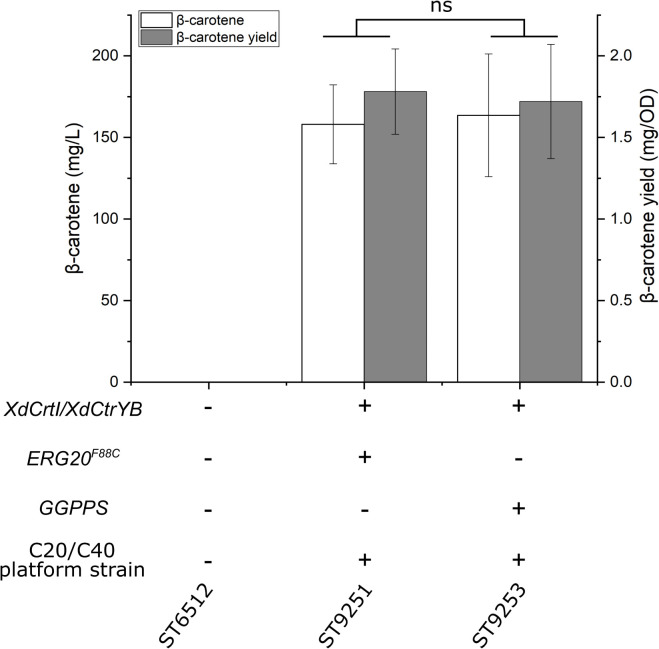
β-carotene production by the diterpene/carotenoid platform strains. XdCrtI, X. dendrorhous phytoene desaturase; XdCrtYB, X. dendrorhous bi-functional phytoene synthase/lycopene cyclase; ERG20F88C, mutated version with geranylgeranyl diphosphate synthase activity; GGPPS, geranylgeranyl diphosphate synthase. The diterpene/carotenoid (C20/C40) platform strain contains the following gene overexpressions HMG, ERG12, ACL, SeACS, and IDI, while the native squalene promoter was swapped (pERG11_SQS). Average values and standard deviations for each strain are based on two individual clones with three biological replicates each. Statistical non-significance is marked with ns (student’s t-test, two-tailed, p > 0.05).